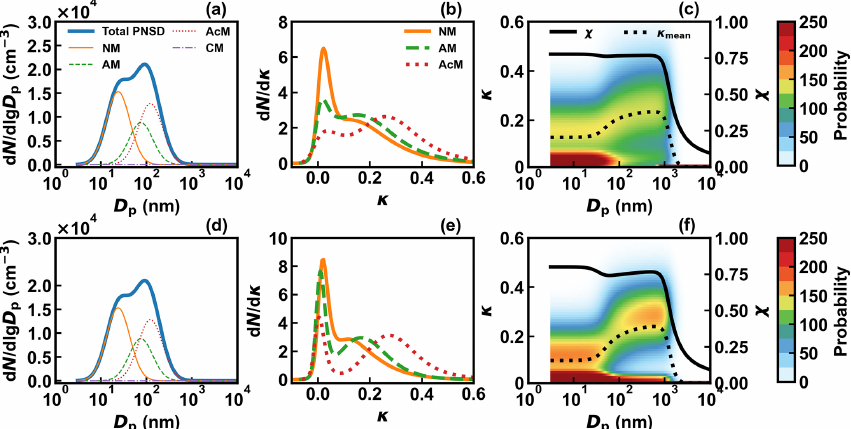
Figure 6. The typical PNSD (a) , (d) and the κ -PDF during the winter (b) and summer campaigns (e) used for calculating the size-resolved κ mean , the size-resolved κ -PDF, and the corresponding size-resolved χ (c) , (f) . The solid lines (blue) in (a) and (d) are the measured PNSD that can be fitted by a four-mode (a nucleation mode (NM), an Aitken mode (AM), an accumulation mode (AcM), and a coarse mode (CM)) lognormal distribution, which is represented by the thin solid line (orange), the dashed line (green), the dotted line (red), and the dash-dotted line (purple), respectively. The corresponding type and color lines represent the measured campaign average κ -PDF for each mode in (b) and (e) . The dotted line in (c) and (f) is the calculated size-resolved κ mean , and the shaded color is the corresponding size-resolved κ -PDF. The solid lines in (c) and (f) are the calculated size-resolved χ